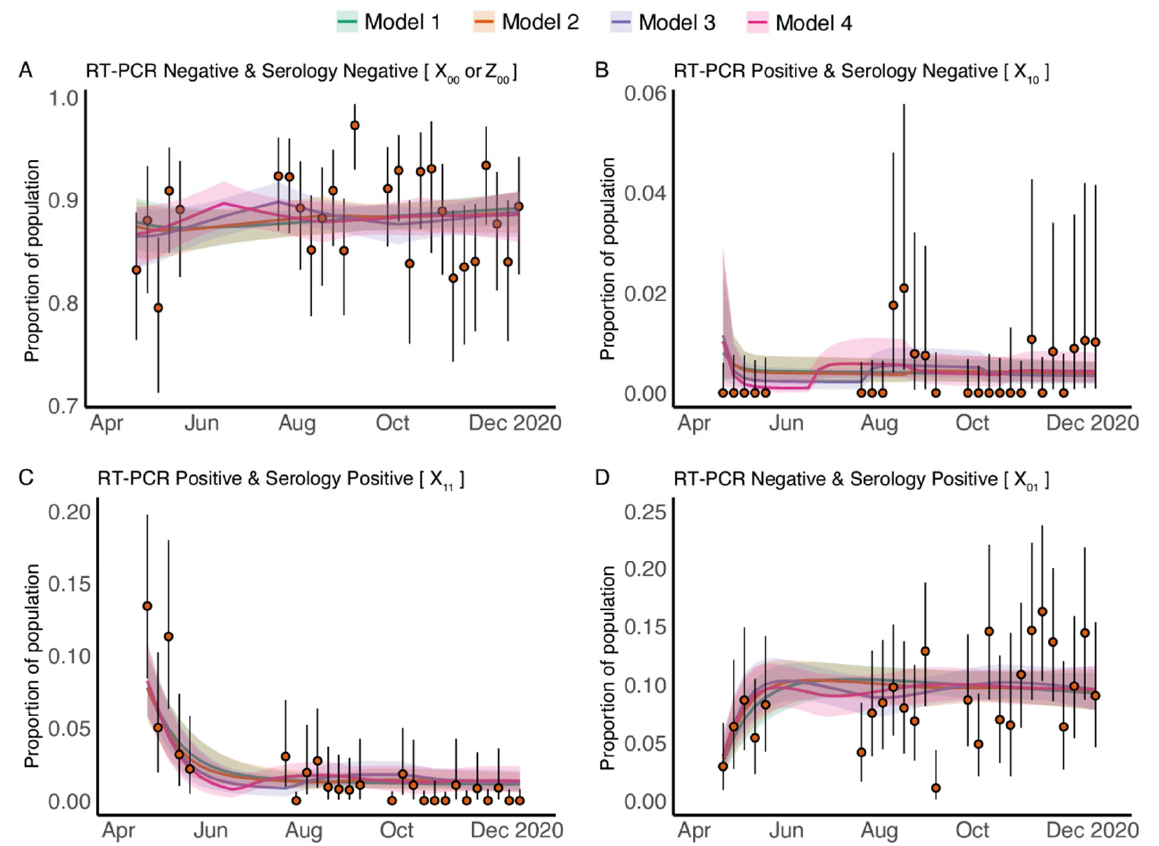
Figure 2. Time evolution measurements and fitted test-result model estimates of the SARS-CoV-2 RT-PCR and antibody status among patients who gave birth between 20 April 2020 and 21 December 2020. Panel ( A – D ), respectively, shows the model fitting results for four data-driven categories: ( A ) both RT-PCR negative and serology negative; ( B ) RT-PCR positive and serology negative; ( C ) both RT-PCR positive and serology positive; and ( D ) RT-PCR negative and serology positive. In each panel, the orange solid circles and black error bars represent the measured proportion of patients who were giving birth and in one of the four RT-PCR and serology categories and their credible intervals respectively. The green, orange, purple and pink lines in each panel show the median of estimates from Model 1–4, for proportions of patients who were giving birth in each of the four categories, while the shaded areas correspond to the 90% credible intervals. The models differ in the time ‐ dependence of the force of infection; Model 1 assumes a constant force of infection while Models 2–4 assume time ‐ varying force of infection. Table 3. Parameter estimates (associated 90% credible intervals) among pregnant patients for each model fit.